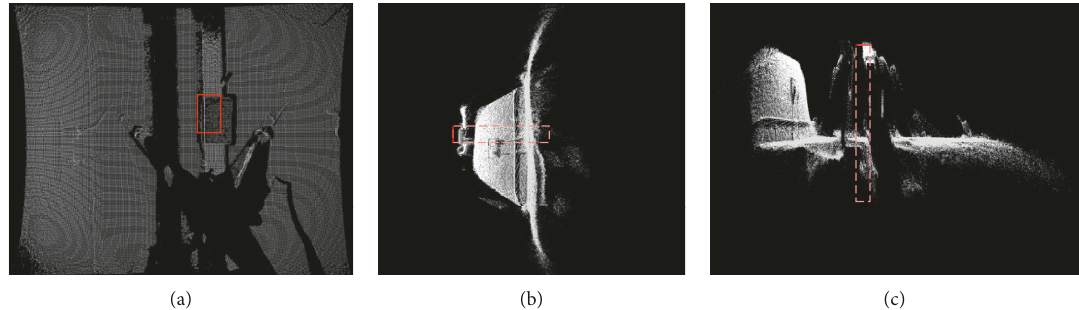
Figure 13: ROI (highlighted in red) for vibration measurement in the simply supported carbon plate experimental case 1. 3D point cloud: (a) front view, (b) left view, and (c) top view.